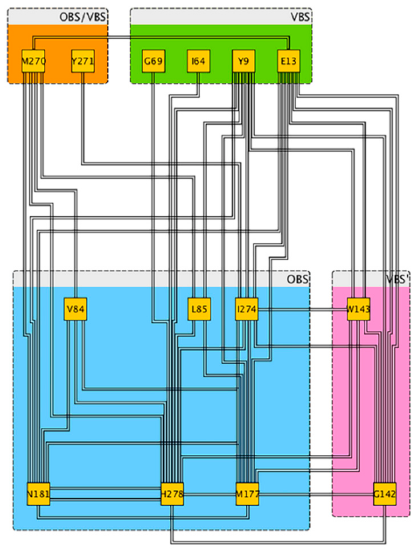
Figure 8. Coevolution relationships between amino acids of the relevant regions studied in this article (Table S4) based on Coeviz web server analyses [46] .